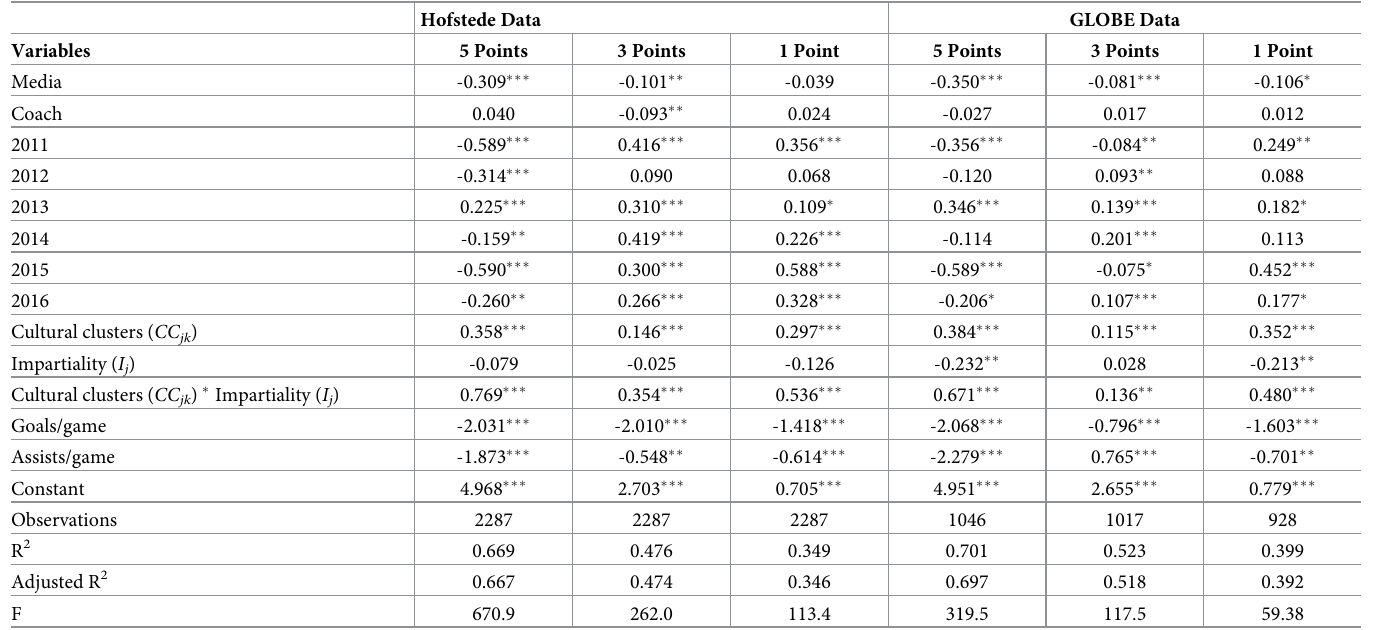
Table 5. Hypothesis 3 (Impartiality): Regression models on voting bias for 5, 3 and 1 points awarded using both Hofstede and GLOBE data